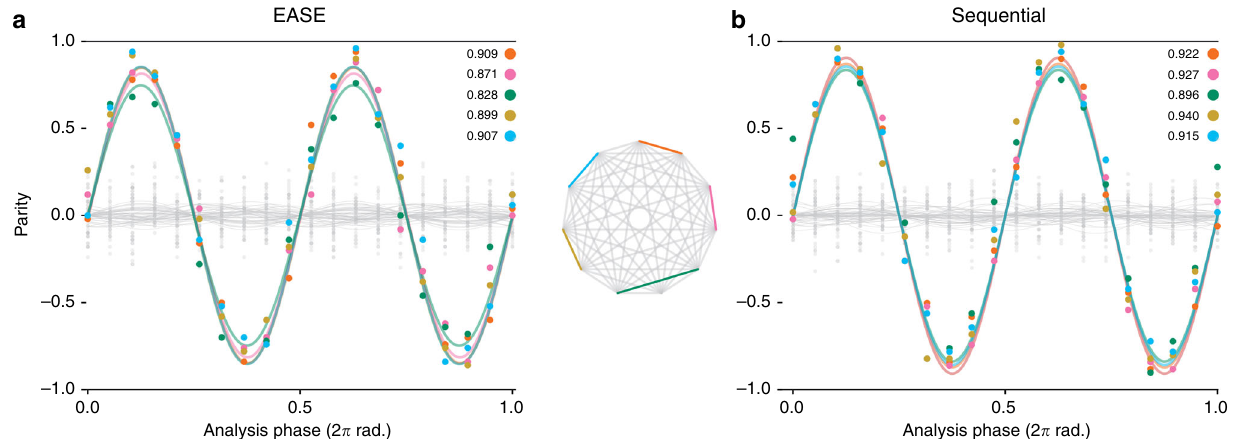
Fig. 3 Parity curves for EASE and sequential gates and a 11-qubit TIQIP all-to-all connectivity diagram. The connectivity diagram displays the ion pairs used in the experiments. The associated fi delities are computed from the amplitudes of the measured parity and populations via maximum likelihood estimation. a Parity curve for an EASE gate with fi ve simultaneous XX interactions. We chose pulses with N seg = 35 and gate time τ = 924.0 μ s. This gate % with an average deviation from the ideal fi delity of 2 : 3 þ 2 : 1 % for the 50 non-involved pairs. b Parity curve for a series yielded an average fi delity of 88 : 3 þ 1 : 0 (cid:2) (cid:2) 1 : 6 1 : 6 of fi ve sequential XX interactions. We chose pulses with N seg = 27 for each XX gate with gate time τ = 318.6 μ s, which yielded an average fi delity of % with an average deviation from the ideal fi delity of 0 : 9 þ 2 : 4 % for the 50 non-involved pairs. To ensure a fair comparison of gate times, we made 92 : 0 þ 0 : 8 (cid:2) (cid:2) 1 : 0 1 : 4 sure that the peak powers at which we executed the EASE and the sequential gates differed by no more than 0.5%. Thus, comparing the EASE and sequential-based approaches to create the same fi nal state of all qubits, application of the EASE gate saved ~669.0 μ s, i.e., 42% of the total gate time needed in the sequential approach. The quoted errors are 1 σ con fi dence intervals from the maximum likelihood estimation. See Supplementary Note 3 for implementation